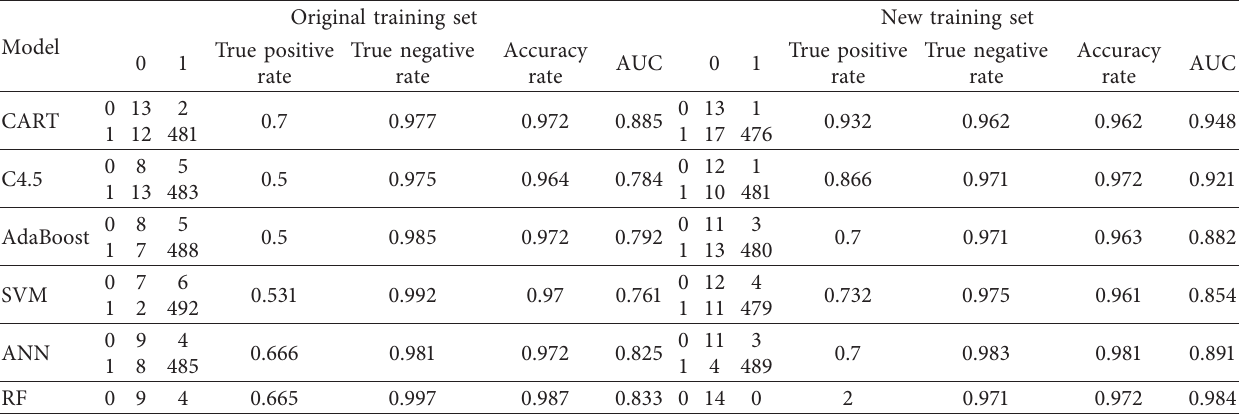
Table 4: Classification results summary of each model.